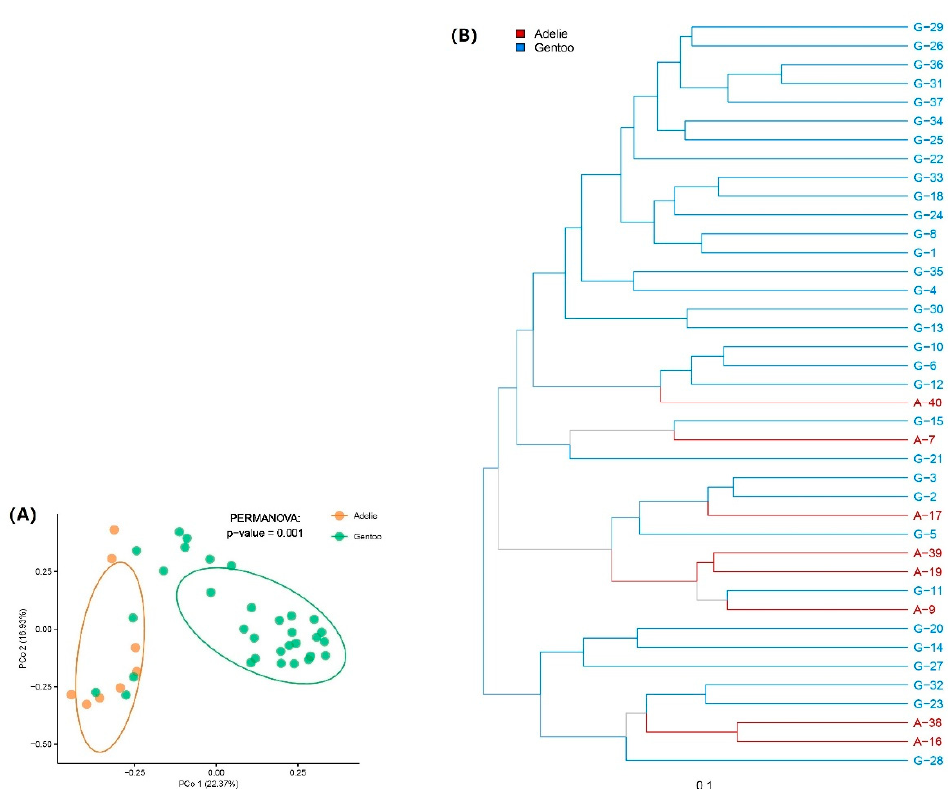
Figure 4. Difference and similarity of bacterial communities between the two pygoscelid penguin groups. ( A ) Principal coordinates analysis (PCoA) of bacterial community composition in feces at the OTU level according to Bray-Curtis distance. ( B ) Hierarchical clustering of bacterial community composition in feces at the OTU level according to Bray-Curtis distance.